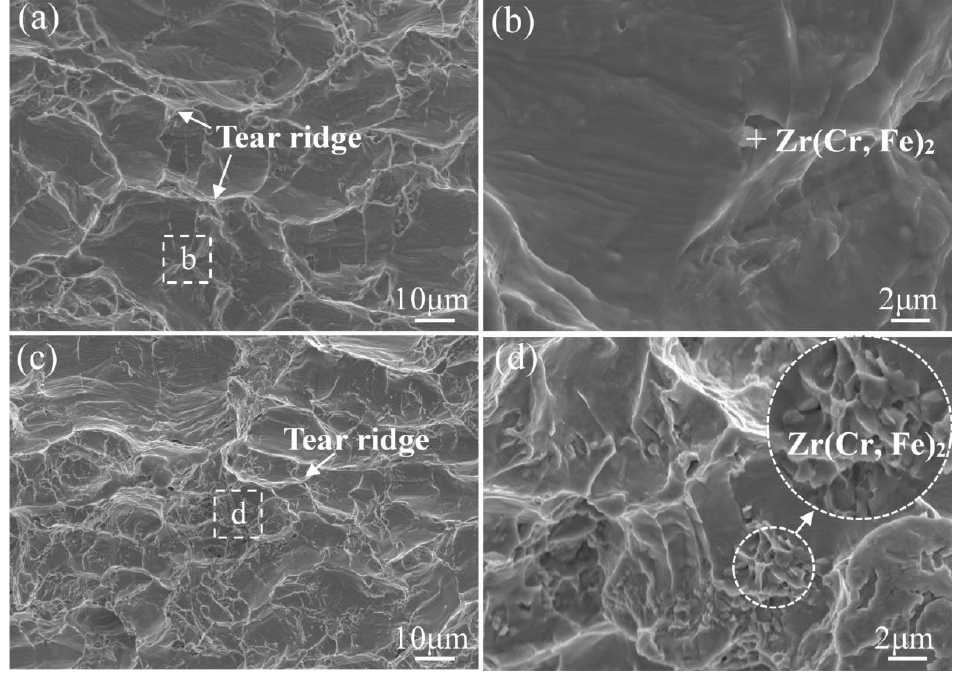
Figure 9. Fracture morphologies of the joint bonded for different holding times (800 °C/7 MPa): ( a , b ) 30 min and ( c , d ) 90 min.